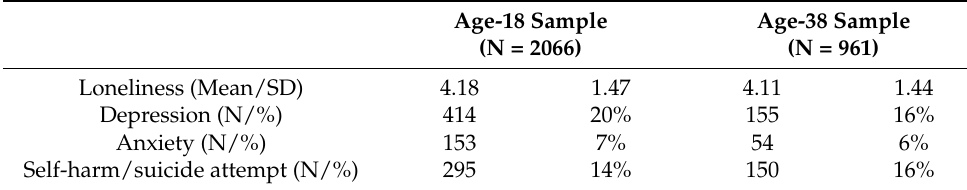
Table 1. Descriptive statistics of loneliness and mental health